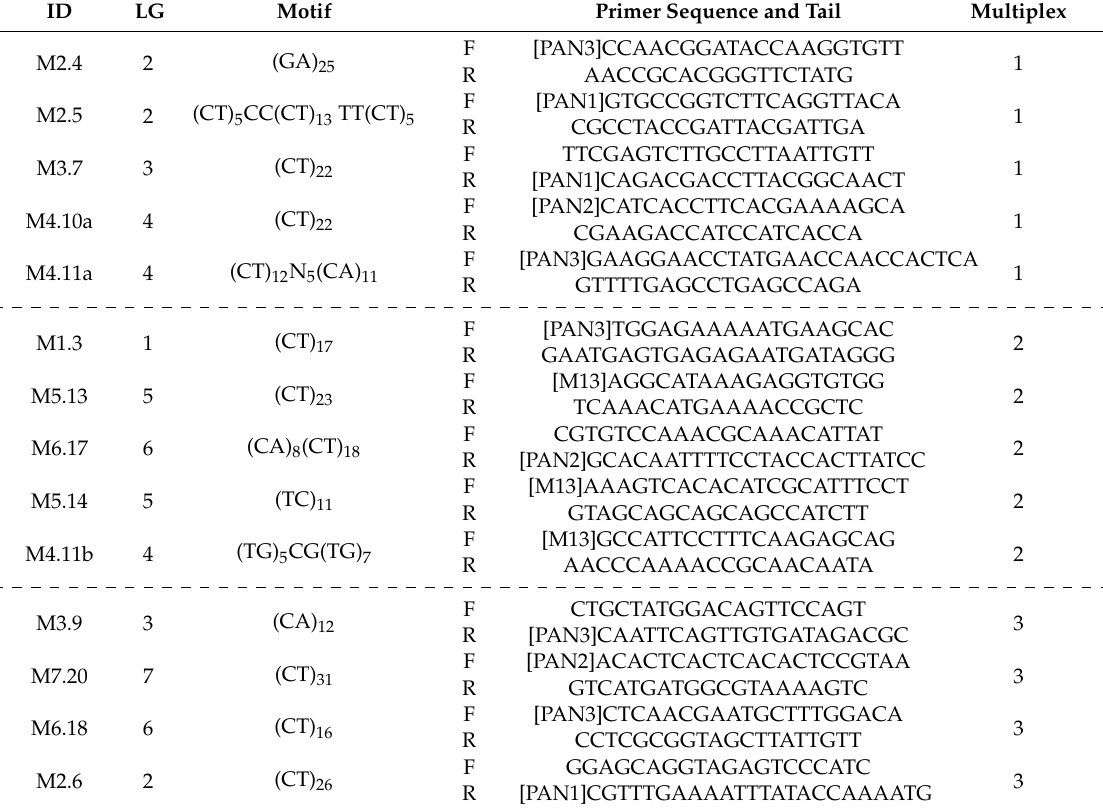
Table 1. Sequence of the primer pairs of 14 simple sequence repeats (SSR) marker loci selected from leaf chicory ( C. intybus ) that produced amplicons that were also in endive ( C. endivia ). The data include the original ID, SSR linkage group (LG), motif, tailed primers used (PAN1, PAN2, PAN3 or M13), and multiplex to which the SSR marker locus belongs. All the microsatellites used in this study were derived from Patella et al.